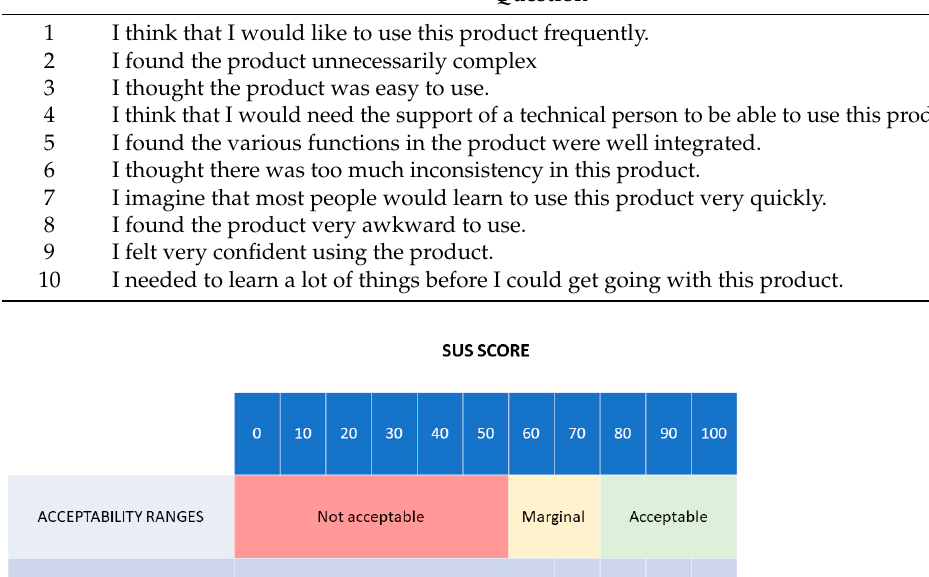
Table 3. System Usability Scale questionnaire (SUS).